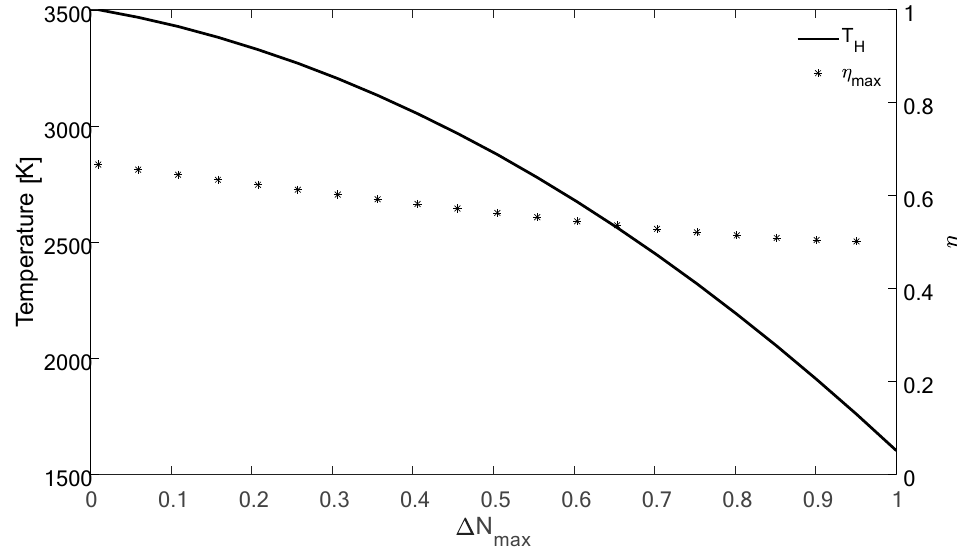
Figure 6. Temperature T H and e ffi ciency at maximum power as a function of the optimal mass conversion fraction.